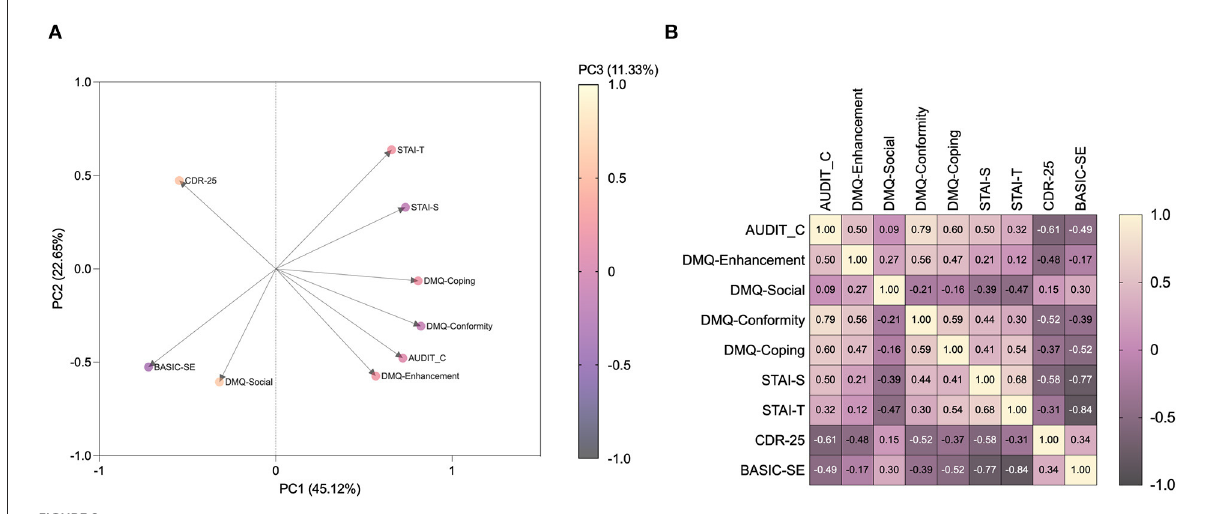
FIGURE2 Anxiety, resilience, self-esteem, and drinking motives correlate with alcohol drinking patterns, neurovegetative and endocrine response. Loading-factor graph of principal component analysis (A) and the correlation matrix (B) show how alcohol drinking pattern and motives co-variate and correlate with anxiety-, resilience- and self-esteem levels observed in high school students. AUDIT-C, Alcohol Use Disorder Identification Test-C; DMQ, Drinking Motives Questionnaire-Revised Short Form; STAI-S/T, State-Trait Anxiety Inventory-State; CDR-25, Connor-Davidson Resilience Scale; BASIC-SE, Basic Self-Esteem